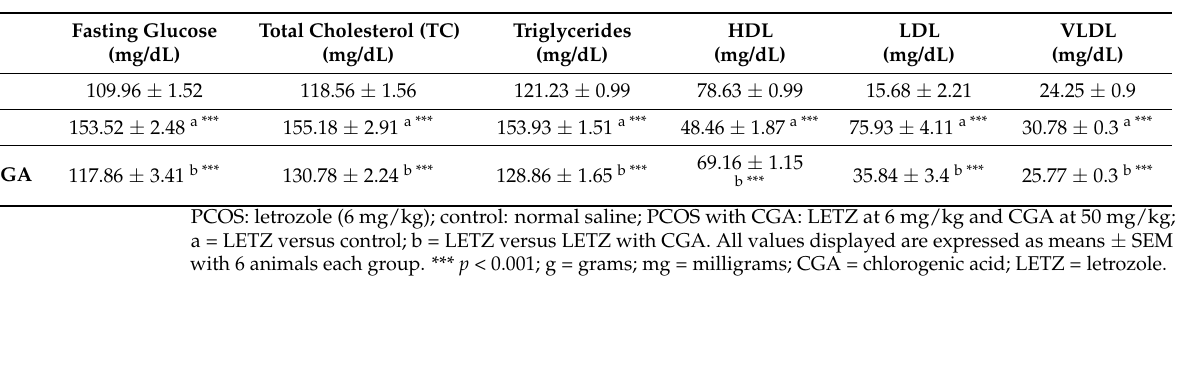
Table 2. Impact of CGA on fasting glucose and lipid profiles in PCOS